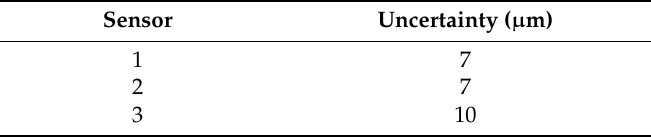
Table 1. Uncertainty for each sensor obtained in laboratory tests.